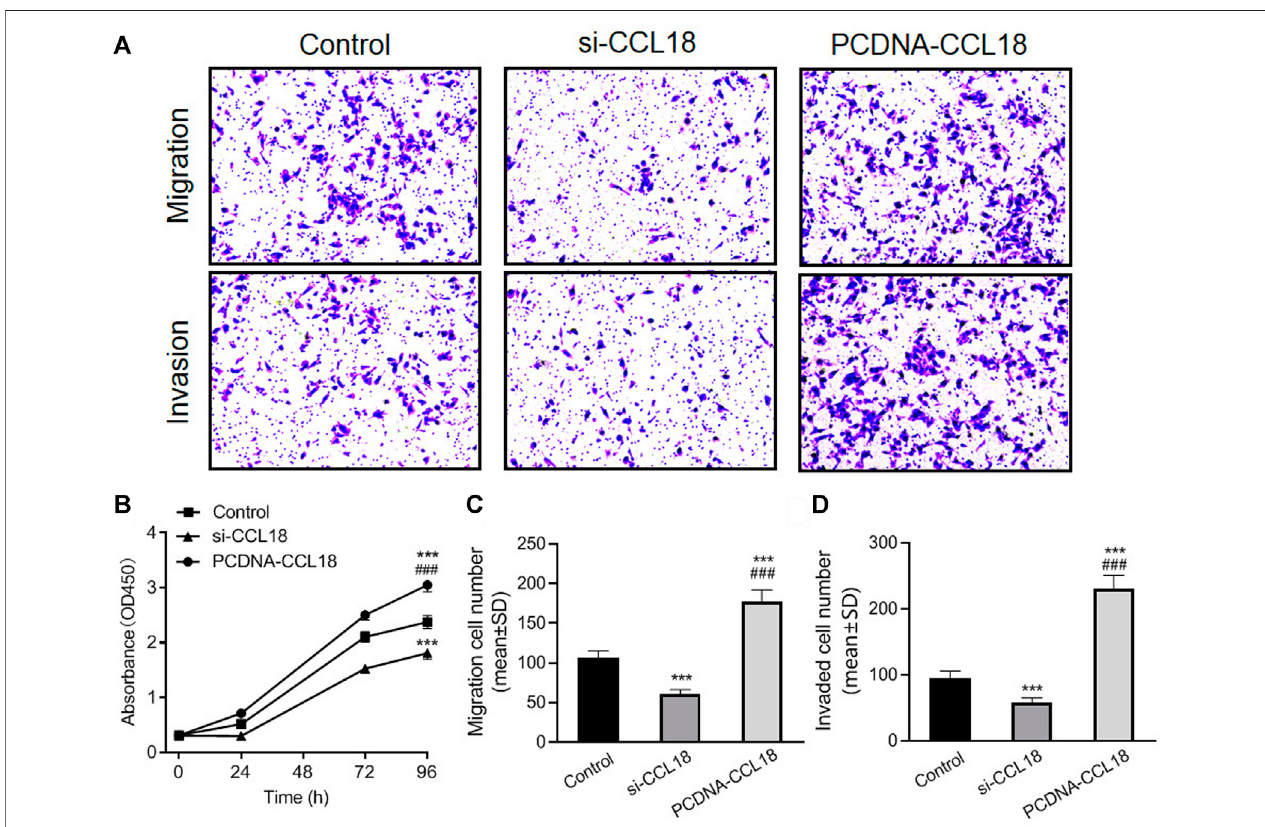
FIGURE 2 | CCL18 promotes proliferation, migration, and invasion of BUC T24 cells. (A) is picture of Transwell cell migration and invasion assay (stained with crystal violet). The migration and invasion ability of BUC T24 was signi fi cantly enhanced after CCL18 overexpression and suppressed after CCL18 silencing. (B) is the statistical result of cell proliferation ability detected by CCK-8 assay. The proliferative capacity of BUC T24 was promoted by CCL18 overexpression and restricted by CCL18 silencing at 96 h time point. (C,D) are the statistical results of migration and invasion, respectively. *** p < 0.001 vs. Control, ### p < 0.001 vs. Si-CCL18.